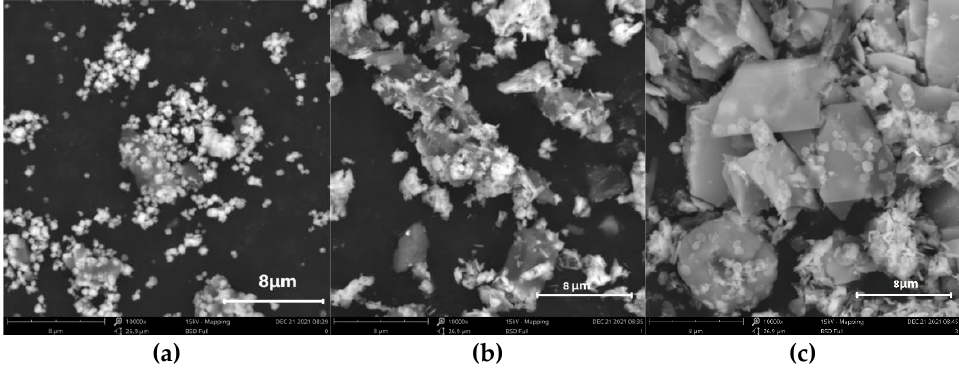
Figure 1. SnO 2 morphology at 200 °C, with 80 mL absolute alcohol, without polyvinylpyrrolidone (PVP), and reaction period of ( a ) 8, ( b ) 12, and ( c ) 48 h.